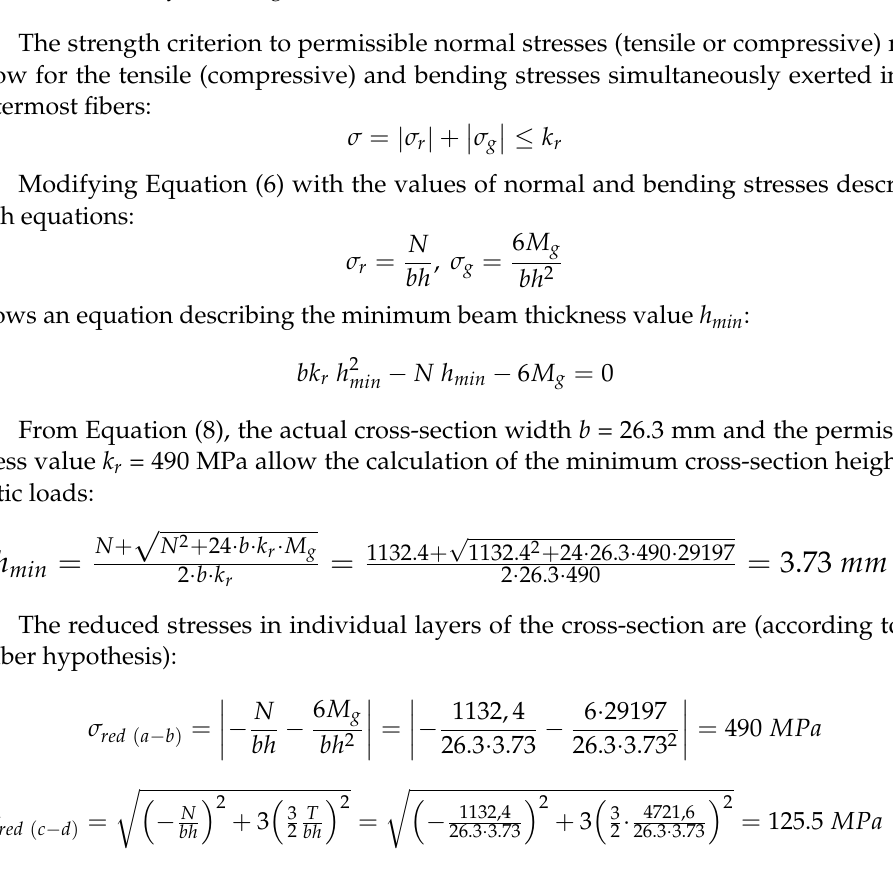
Figure 7. Internal forces in the restraint cross-section and the stress distributions. Symbols: M g — bending moment; N —normal force; T —shearing force; C —center of the cross-section area; a–b , c–d , e–f —cross-section layers having characteristic distributions of normal and static